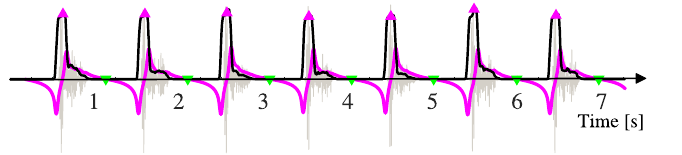
Figure 10. An example of a AR sound from database 26